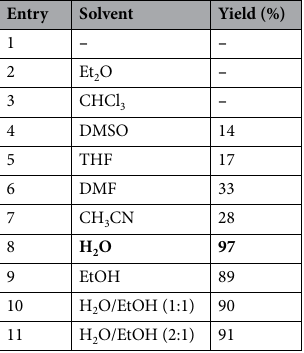
Table 4. Optimization of reaction conditions for the synthesis of compound 4a . The reaction of 1a (1 mmol), 2 (3 mmol), 3 (1 mmol), catalyst (15 mmol) and solvent (2 mL) under microwave irradiation was carried out. Significant values are in